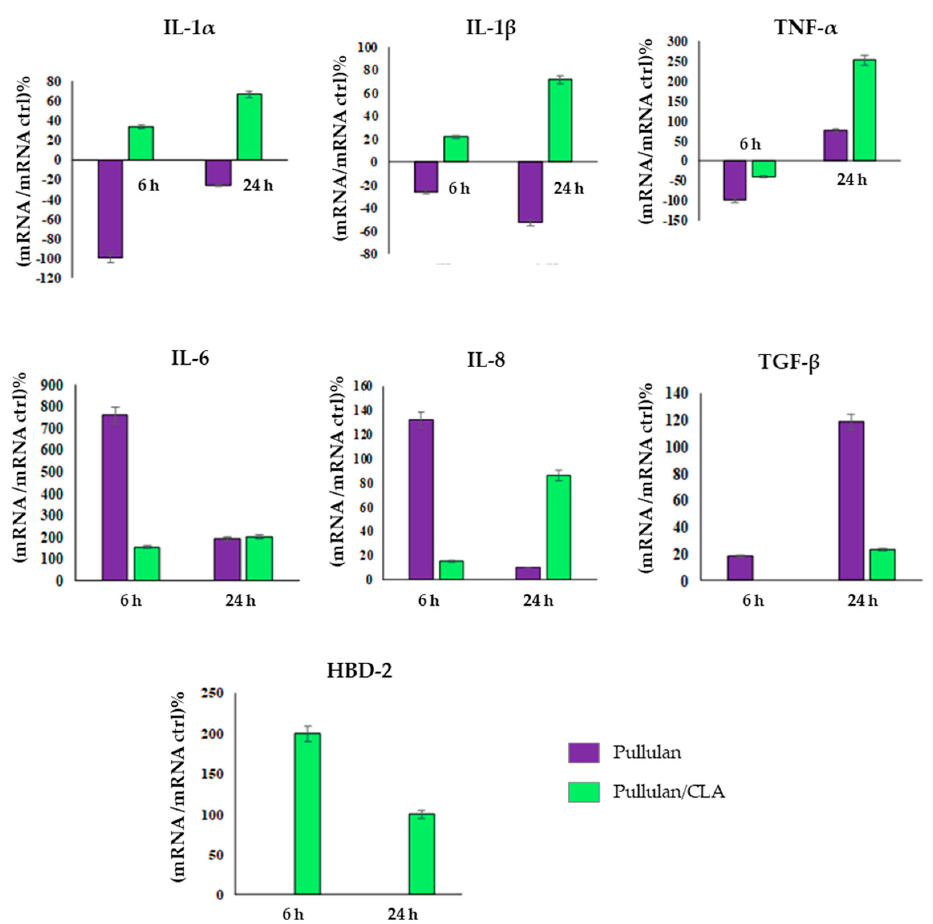
Figure 9. Relative gene expression of HBD-2 by HaCaT cells in contact with pullulan and pullulan / CLA (beauty mask) for 6 h and 24 h. Data are reported as mean ± SD and are expressed as percentage of increment relative to untreated HaCaT cells (as controls; ctrl). [CLA stands for